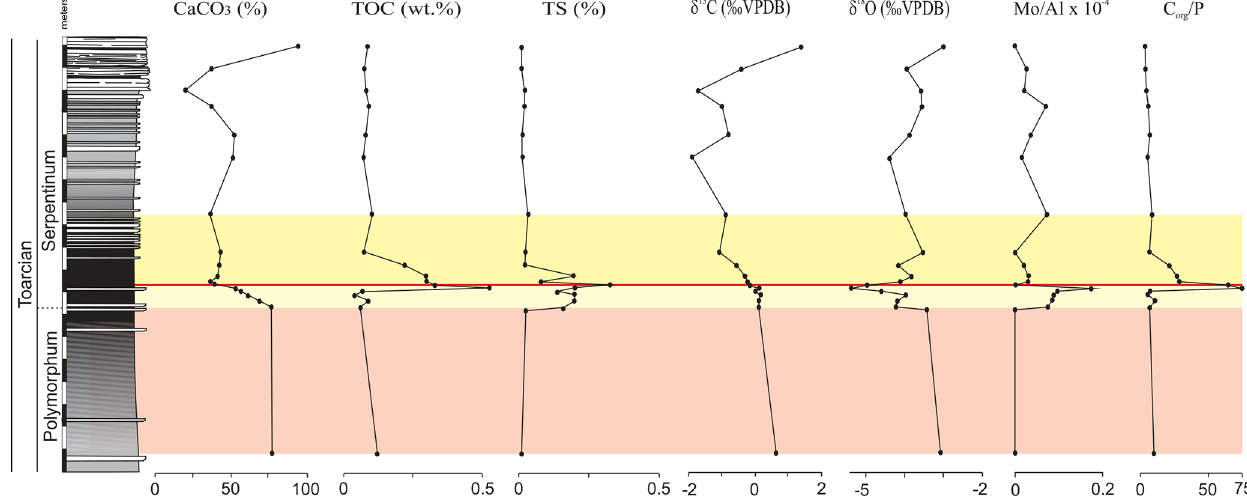
Figure 4. Stratigraphic distribution of the geochemical proxies CaCO 3 , TOC, TS, δ 13 C, δ 18 O, and the Mo / Al ratio in the Polymorphum– Serpentinum Zone boundary. The colour bands correspond to the stratigraphic intervals differentiated according to microfossil assemblages (see text), and red lines indicate the position of a barren benthic